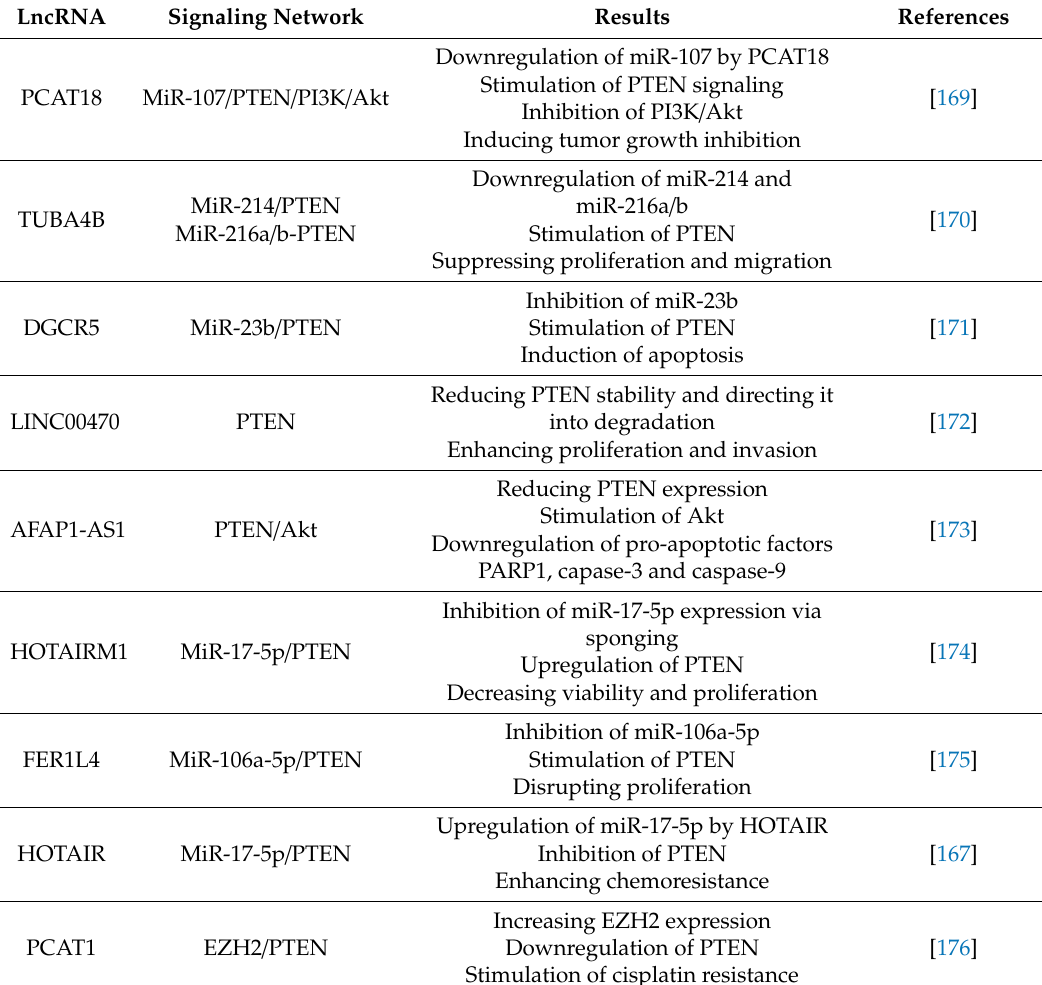
Table 2. LncRNAs regulating PTEN in GC cells and their relationship with proliferation and